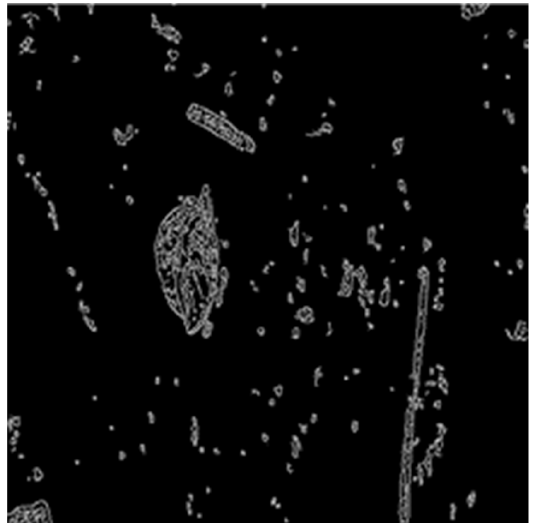
Figure 6. Traditional Canny operator.